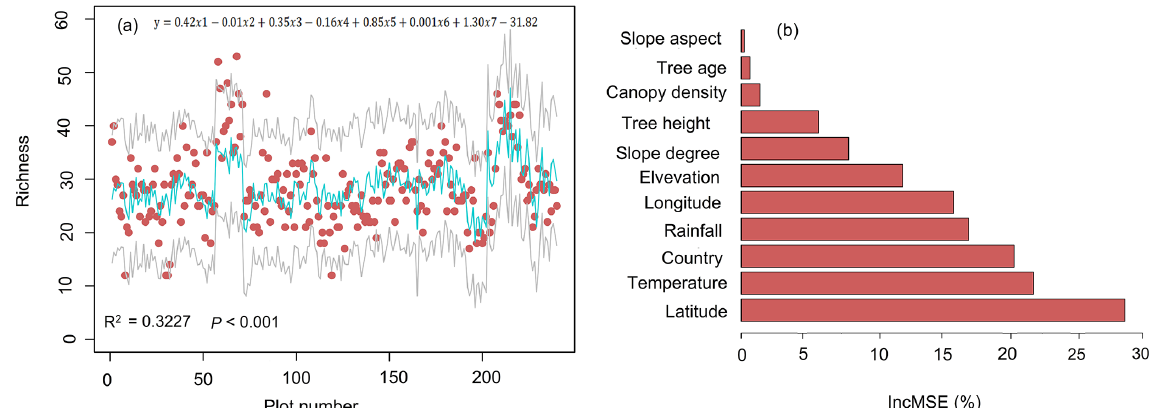
Figure 6. Factors affecting plant diversity of rubber plantations. (a) Predicting species richness by using multiple linear regression (the red point was the observed richness, the green solid line was the estimated richness, and the grey solid line was the 95% confidence interval; y : richness; x 1 : latitude; x 2 : elevation; x 3 : slope; x 4 : age; x 5 : height; x 6 : rainfall; x 7 : temperature). (b) Predictions of the importance of environmental variables based on random forest. IncMSE stands for increase in mean squared error.